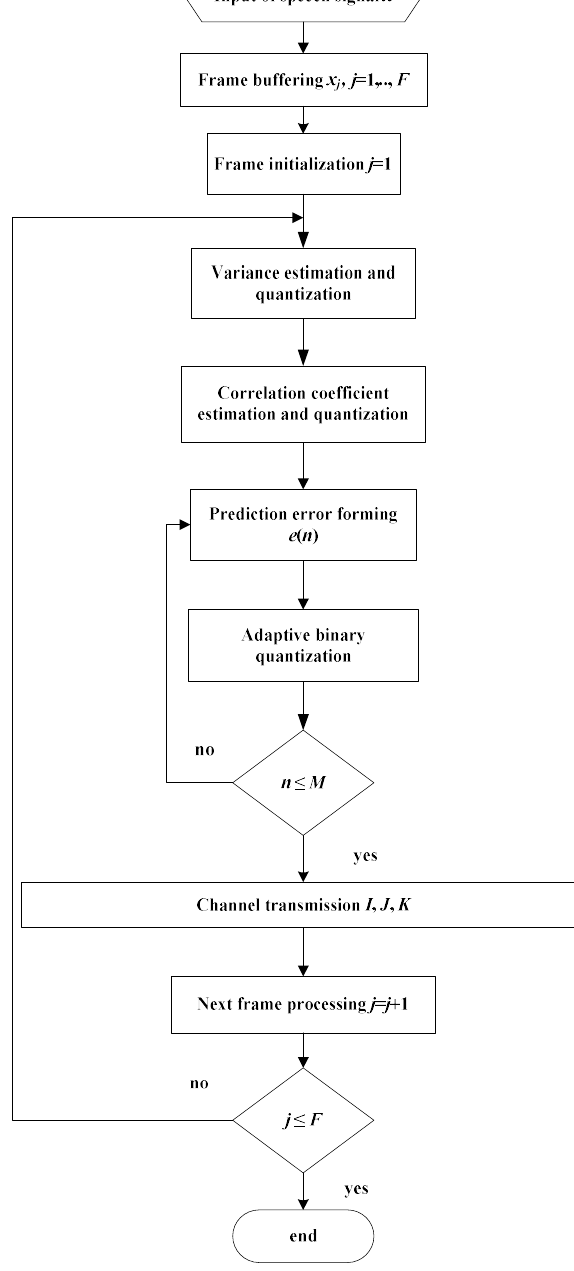
Figure 11. Adaptive delta modulation algorithm with a binary quantizer.